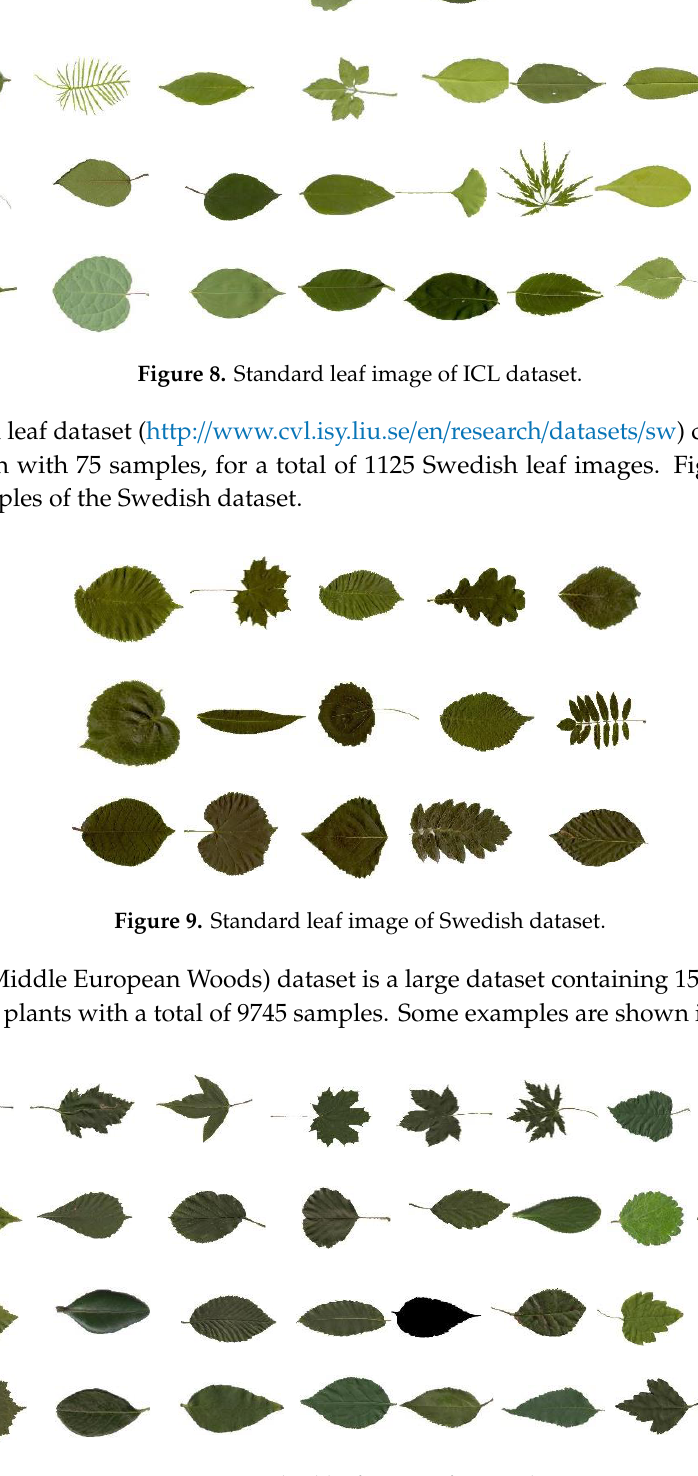
Figure 10. Standard leaf image of MEW dataset.